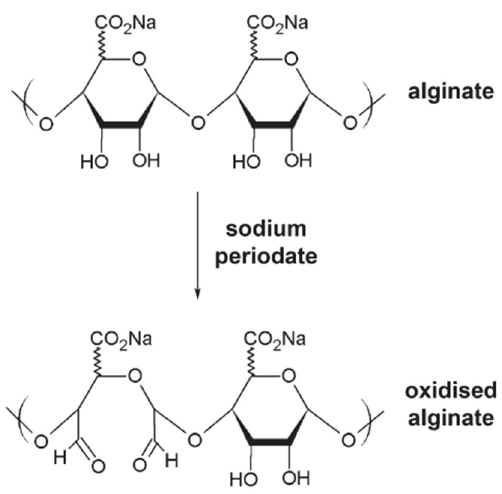
Figure 5. Sequential oxidation of alginate to yield alginate oxidized by sodium periodate [307].